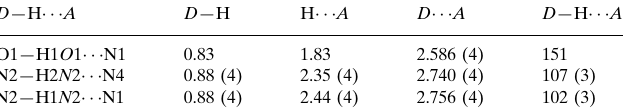
Hydrogen-bond geometry (A ˚ , (cid:2)